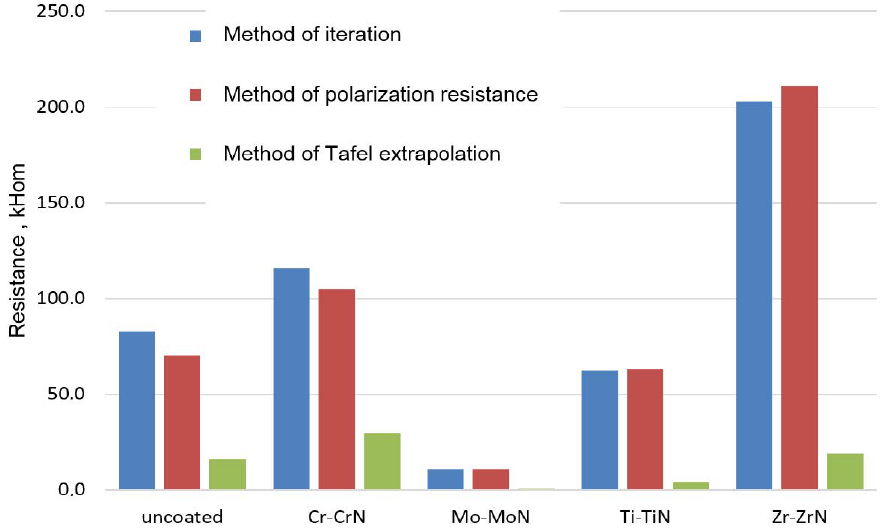
Figure 9. Comparative diagram of the polarization corrosion resistance values for the plates made of Ti-6Al-4V alloy and coated with Cr-CrN, Ti-TiN, Zr-ZrN, and Mo-MoN coatings in the 3 wt.% solution of NaCl, defined by mathematical modeling of the corrosion process by the iteration methods.